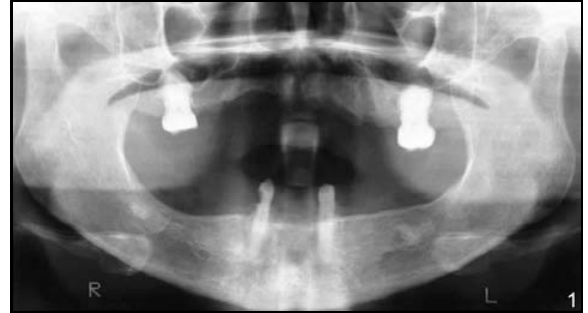
Figure 1 – Orthopantomograph showing an osteogenic reaction of the subjacent bone. A relationship with the bone is not